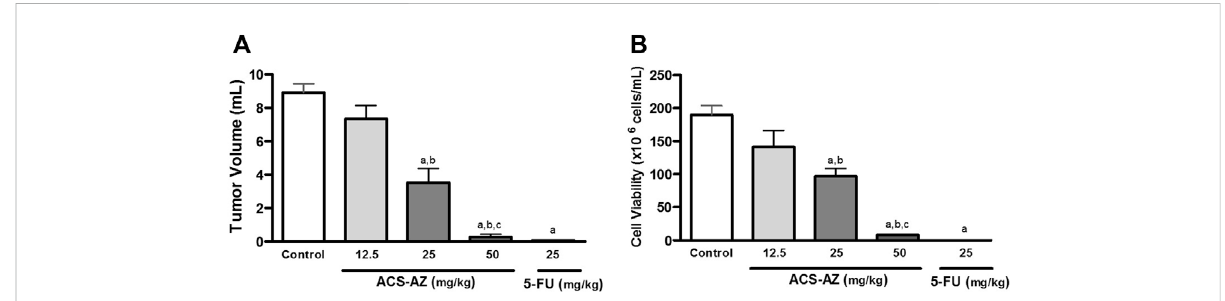
FIGURE 2 Effectsofa7-daytreatmentwithACS-AZ(12.5,25,and50 mg/kg)or5-FU(25 mg/kg)byintraperitonealrouteon (A) tumorvolume(ml),and (B) cell viability (x10 6 cells/mL) in Ehrlich ascites carcinoma-bearing mice. Cell viability was determined by Trypan blue assay. The results represent the mean ± SEM ( n = 8) analyzed by one-way ANOVA followed by Tukey test: a p < 0.05 vs. control group; b p < 0.05 vs. 12.5 mg/kg ACS-AZ group; c p <